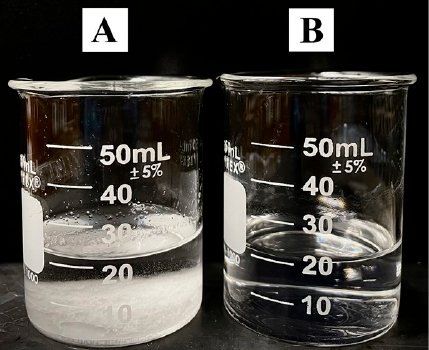
Figure 1. Effect of the presence of LA on the dissolution of PEMA shown by 10 gL − 1 PEMA in ( A ) ethanol, ( B ) ethanol with 1 gL − 1 LA.